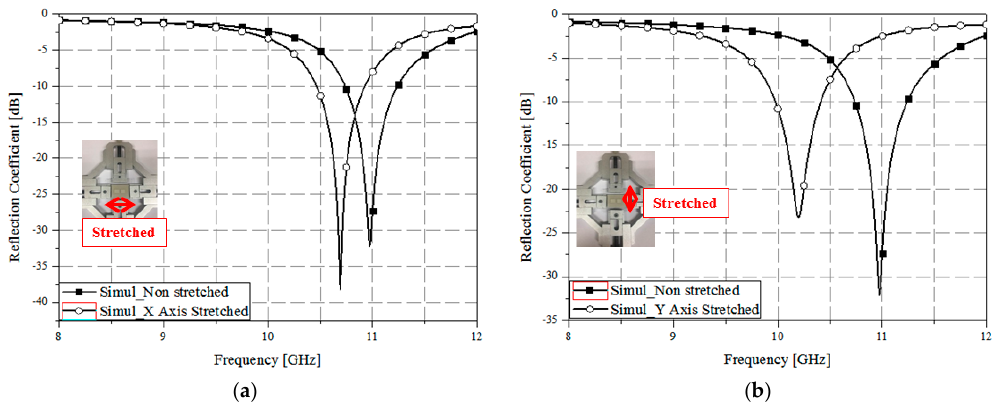
Figure 4. Simulated S-parameter of the absorber stretched along ( a ) the x -axis and ( b ) the y -axis.